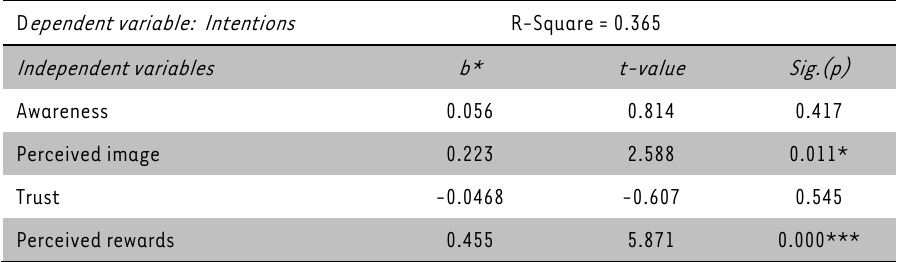
TABLE 7: Influence of the independent variables on the dependent